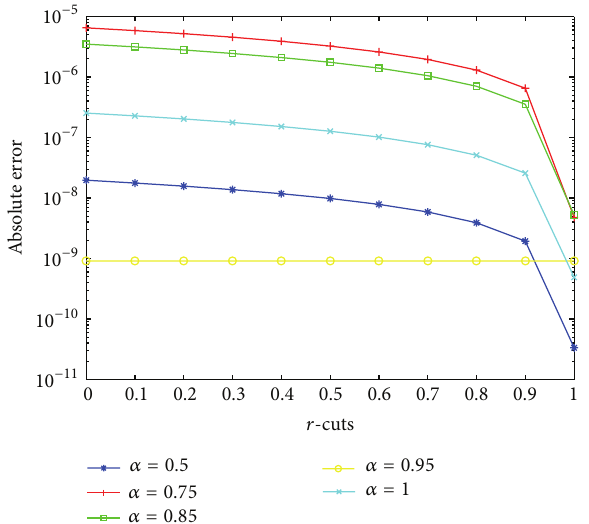
Figure 14: The absolute error for different values 𝛼 with V = 0.95 , = 0.014 , 𝑚 = 8 , and 𝑘 𝑘 1